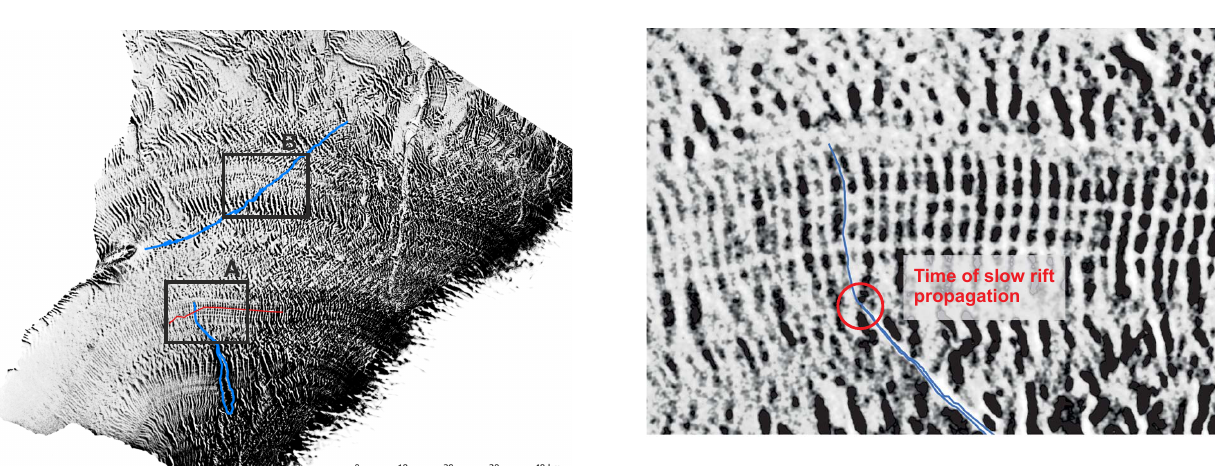
Figure 12. Detailed view of the tip of the Chasm 1 crack (blue curve). The background image distinguishes areas with meteoric ice (dark) from areas with sea ice overlain by firn. When the crack went through one of the blocks of meteoric ice rather than around it (red circle), the rate of propagation slowed.